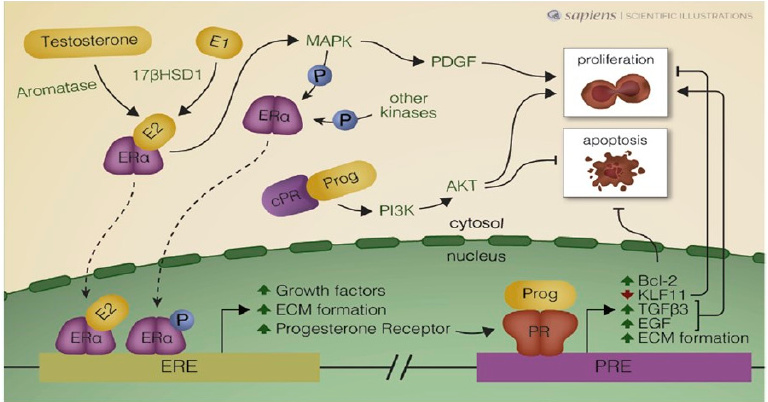
Figure 2. Schematic illustration of autocrine and paracrine mechanisms activated by estrogen receptor alpha (Era) and progesterone receptors (PRs) in uterine leiomyoma cells. Estradiol (E2) arrives with the blood supply (endocrine), but is also synthesized within cells (autocrine), from precursors such as testosterone and estrone (E1). ERa may be phosphorylated (P) by kinases and interact with estrogen response elements (EREs) in the nucleus. 178HSD1: 178-hydroxysteroid dehydrogenase type 1; MAPK: mitogen-activated protein kinase: PDGF: platelet-derived growth factor; P13K: phosphatidylinositol-3-kinase; AKT: serine / threonine protein kinase: Bcl-2: B-cell leukemia / lymphoma-2 protein; KLF: Kruppel-like transcription factor 11; TGF-83: transforming growth factor beta 3;EGP: epidermal growth factor; ECM: extracellular matrix; Prog: progesterone; R: progesterone receptor in the cytosol and PRE: progesterone response element. From Reis et al. Best Practice & Research, Clinical Obstetrics and Gynaecology (2015), with permission from the editor and author.